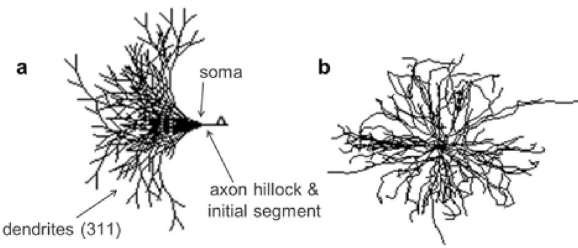
Figure 6. ( a ) 2D and ( b ) 3D representations of alpha motor neuron.